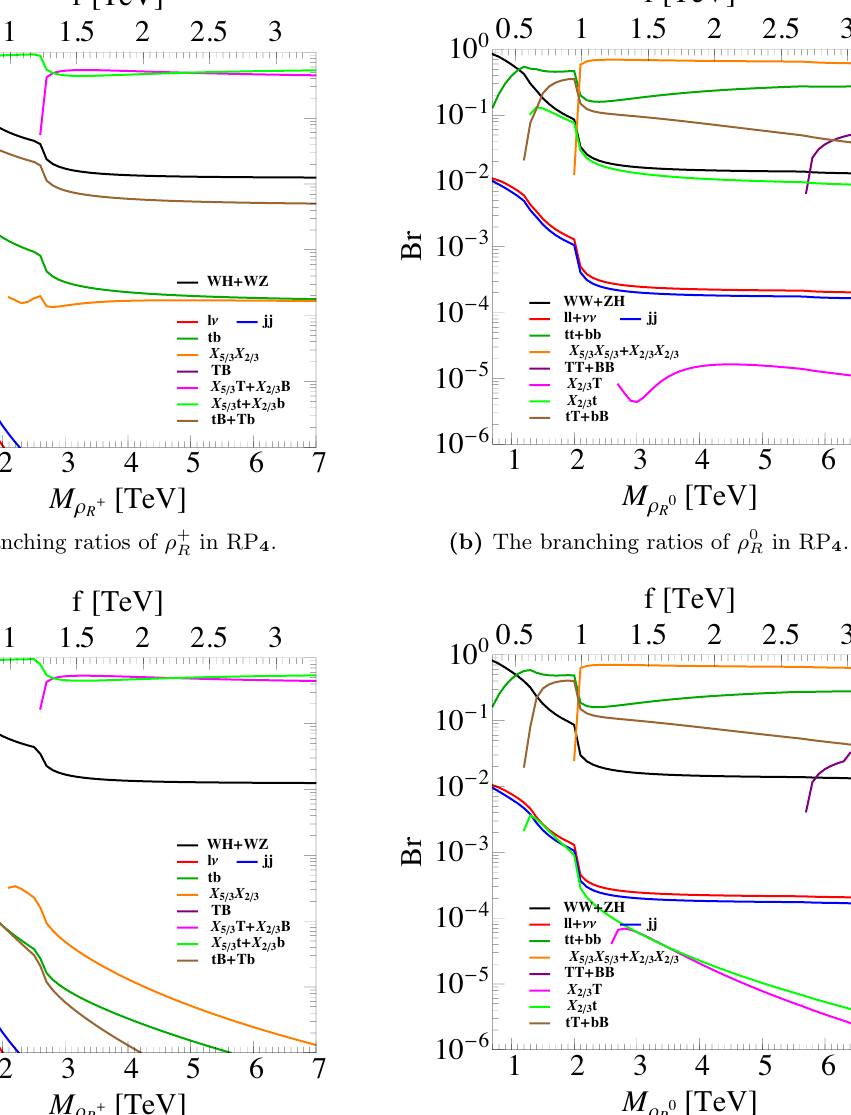
(c) The branching ratios of (cid:26) + Figure 5. The decay branching ratios of the (cid:26) (cid:6) ; 0 a 2 = 1 = 2, M 4 = 1 TeV, y L = 1 and c 1 = 1. For RF 4 there is an additional parameter c 2 = 1. The (cid:26) R Br( T (cid:22) B ) in sub(cid:12)gures (a) and (c) are less than 10 (cid:0) 7 , thus not shown in the (cid:12)gures.